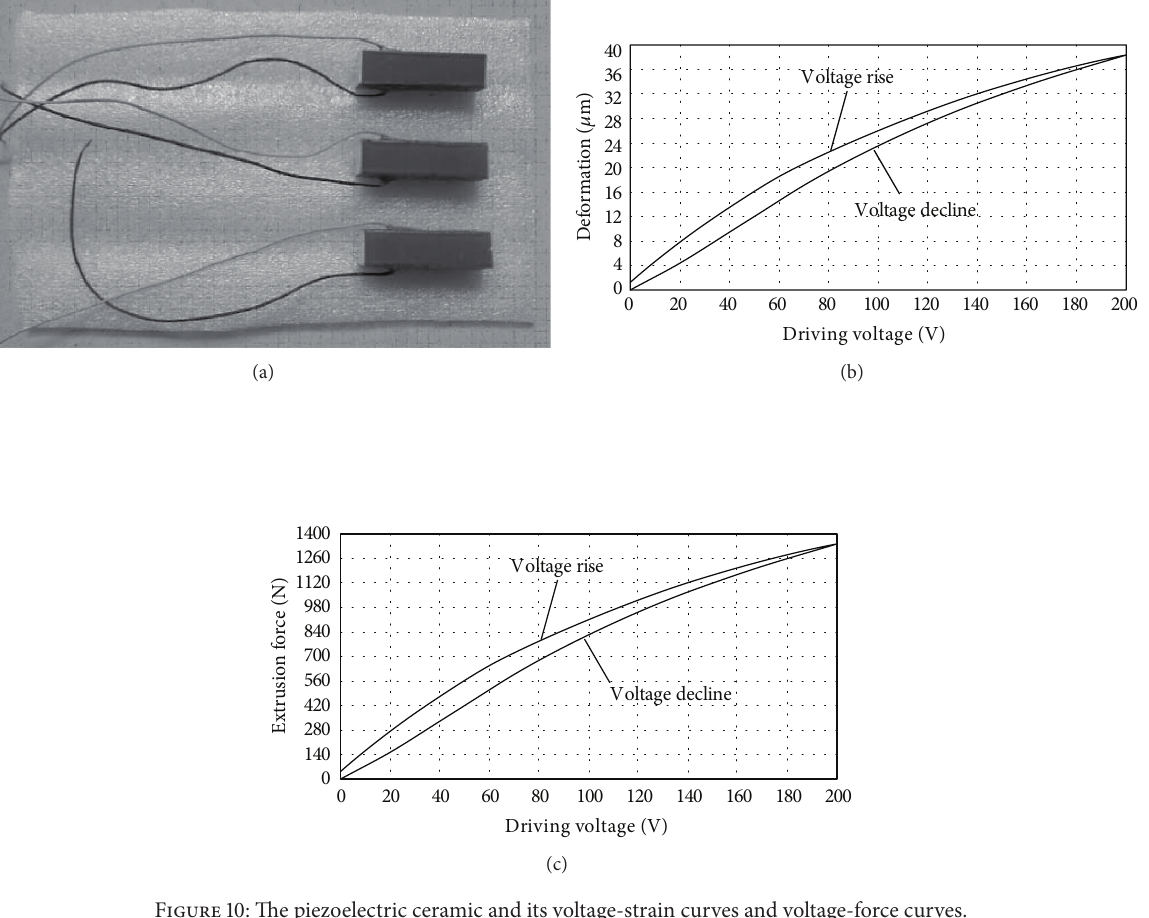
Figure 10: The piezoelectric ceramic and its voltage-strain curves and voltage-force curves.